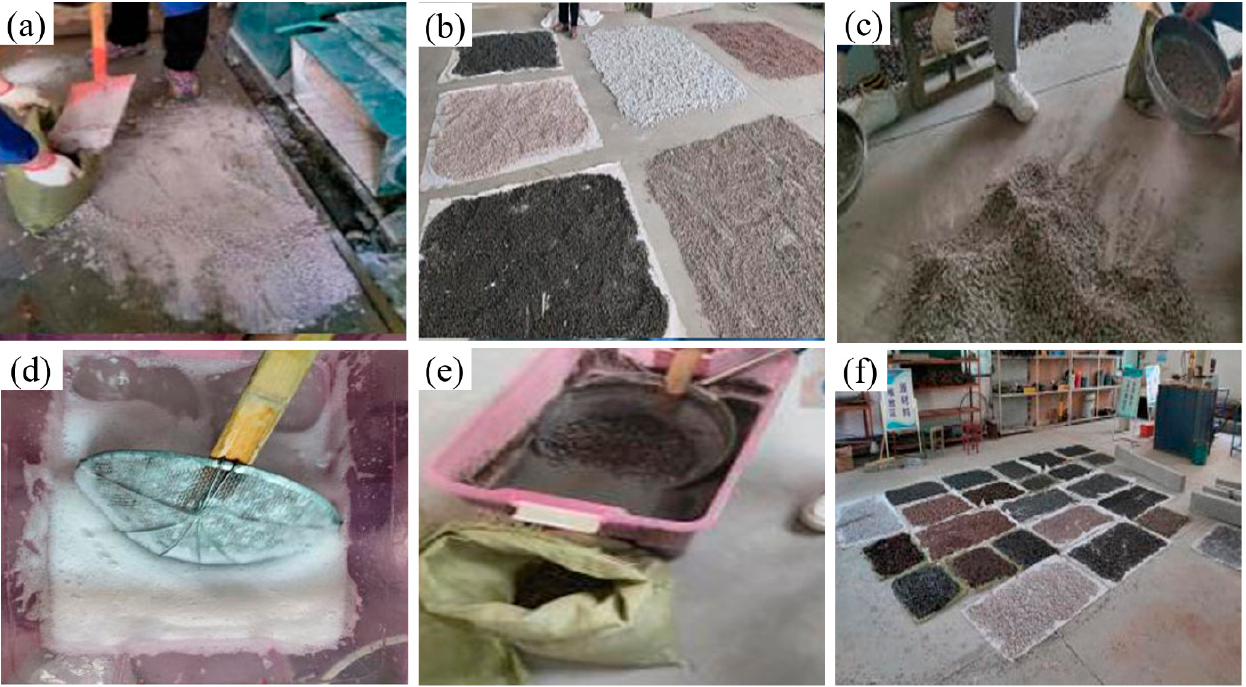
Figure 1. Procedure for the strengthening of recycled aggregates: ( a ) dry mixing, ( b ) curing after dry mixing, ( c ) removing excess fines, ( d ) preparing solutions for slurry coating, ( e ) slurry coating, and ( f ) curing after slurry coating.